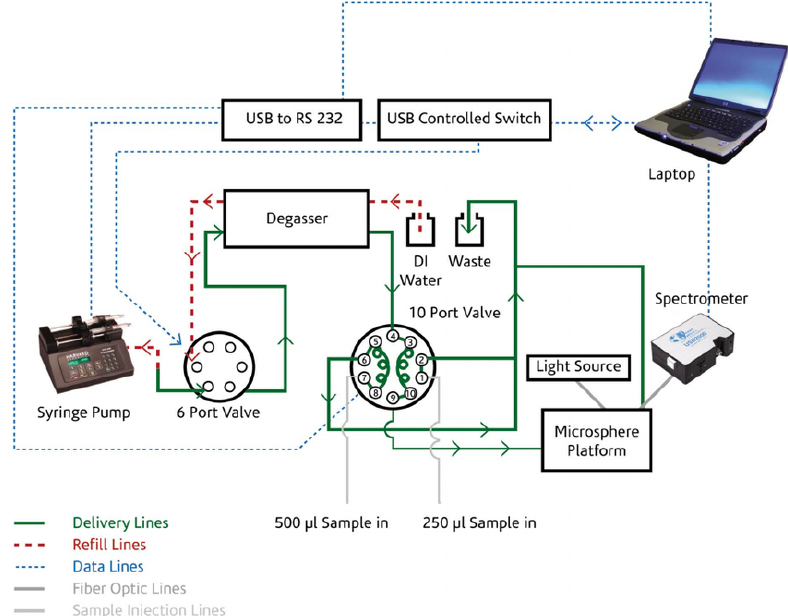
Figure 10. An experimental setup for WGMR biosensing, which includes the controls of the flow of water and analyte-containing solutions past the microsphere. Reprinted with permission from [141].